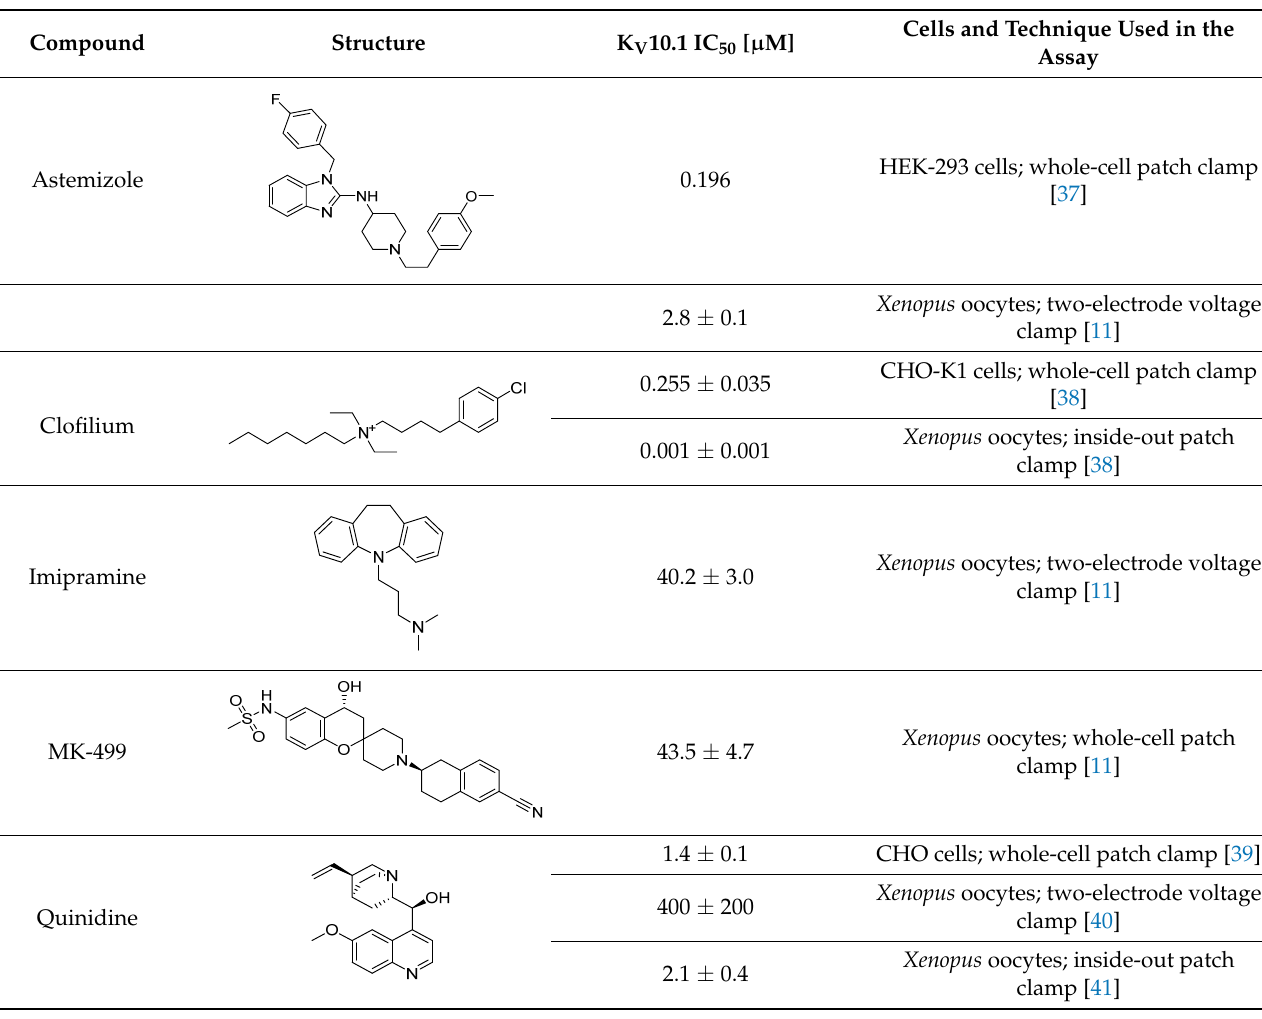
Figure 1. ( A ) Best homology model of the transmembrane part of the K V 10.1 channel in the open conformation, with only two opposing subunits shown for better clarity. The subunits are colored by domain: S1, yellow; S2, orange; S3, red; S4, purple; S5, blue; S6, brown; pore, green; rest of protein not embedded in the membrane, gray. The selectivity filter in the pore domain is shown as green sticks. ( B ) Enlarged view from ( A ) (as indicated) to show the central cavity that is the binding site for various K V 10.1 pore blockers, with only three subunits shown for clarity. The binding site is shown as a gray surface, with astemizole in blue sticks, oriented into one of the hydrophobic side pockets below the selectivity filter.